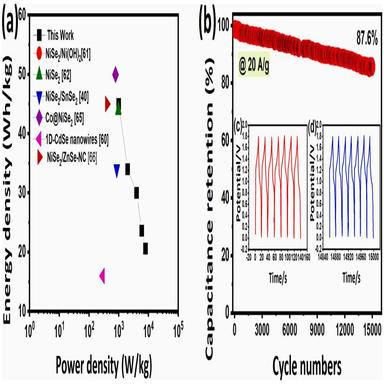
(a) Ragone plot, (b) stability test of the CN-2//AC hybrid supercapacitor in aqueous electrolyte.